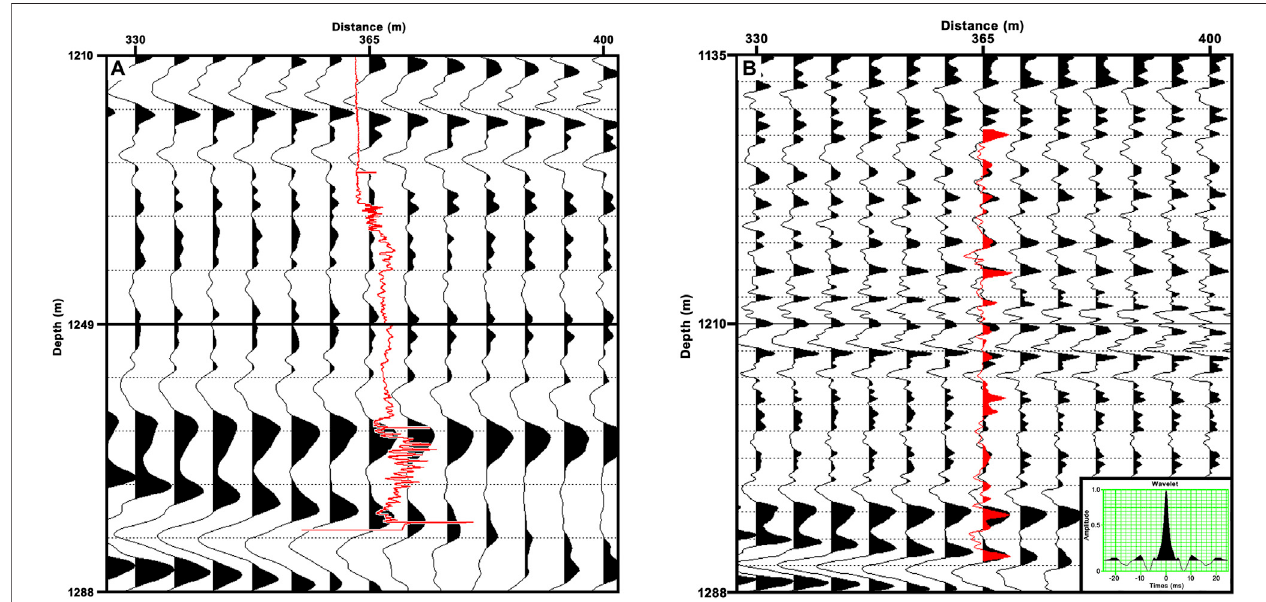
FIGURE 10 | (A) The comparison of VCS imaging section through Site SH7. The red curve is the P-wave velocity from the logging data at Site SH7. (B) Synthetic seismogram (the red curve) intersects the imaging section.